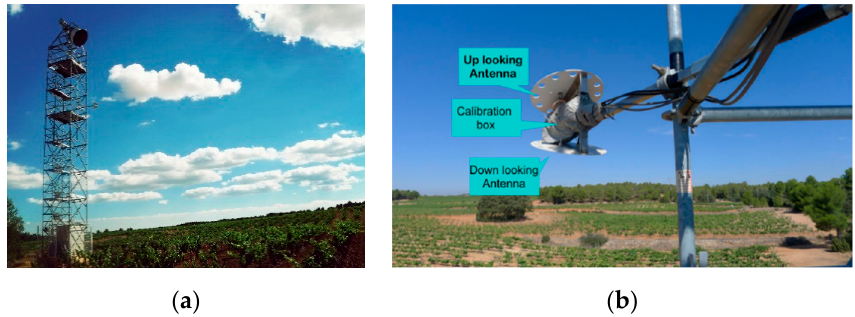
Figure 1. ( a ) ELBARA-II L-band radiometer tower also holding the Oceanpal GNSS-R antennas over a vineyard field at El Renegado MELBEX site at the Valencia Anchor Station; ( b ) Detail of the GNSS-R deployment indicating the essential elements.